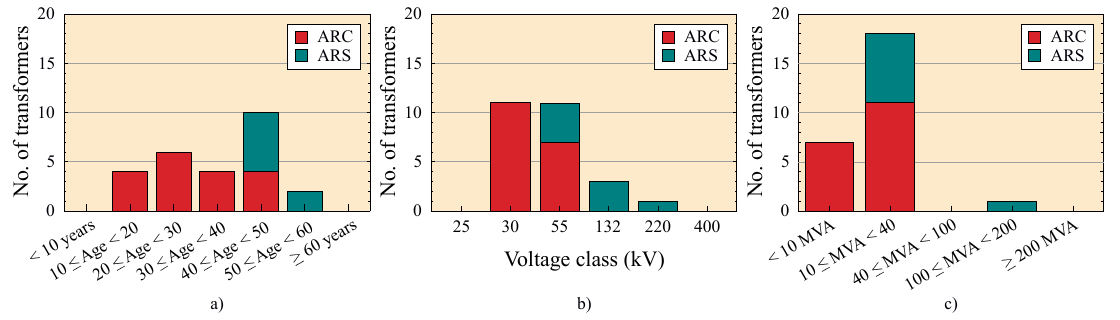
Figure 8. Distribution of power transformers defined as contaminated according to ( a ) age, ( b ) voltage class and ( c ) power